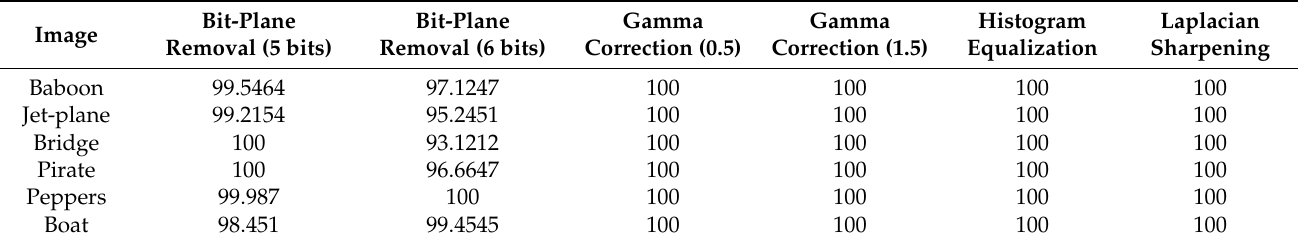
Table 6. Robustness against filtering and bit plane attacks in terms of BCR (%).